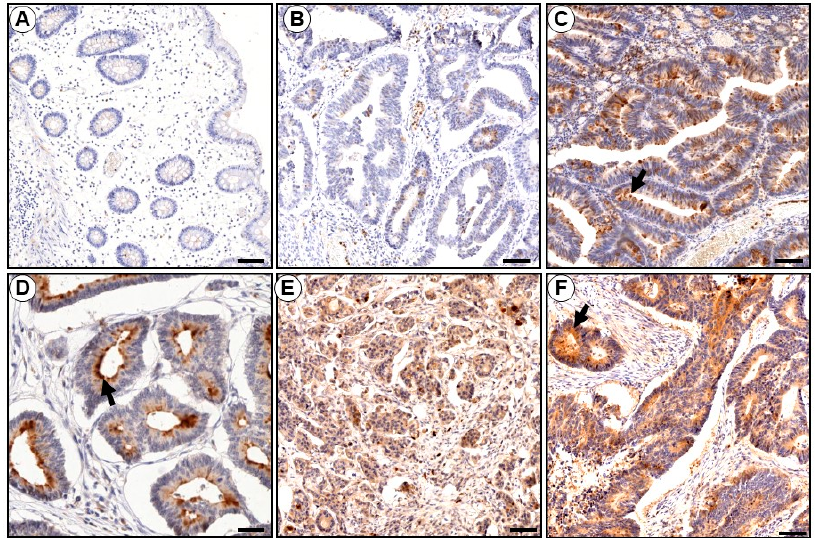
Figure 8. Representative immunostaining of the KLK6 in paraffin sections of colonic tissues from patients with adenocarcinoma. ( A ) KLK6 immunoreactivity is absent in ‘normal-appearing’ colonic mucosa very distant (more than 10 cm) from a colon adenocarcinoma ( B ) Immunostaining for KLK6 in the dysplastic colonic mucosa from the same patient as in ( A ) is seen. ( C – F ) Moderate to strong positive immunoreactivity in the adenocarcinomas of four different patients. KLK6 immunoreactivity appeared to be distinguishable into a predominantly apical/cytoplasmic pattern (arrows). Bar =100 μ m ( A – F ), 10 μ m ( D ). Table 1. Estimation of KLK6 expression in colon carcinoma epithelial cells.